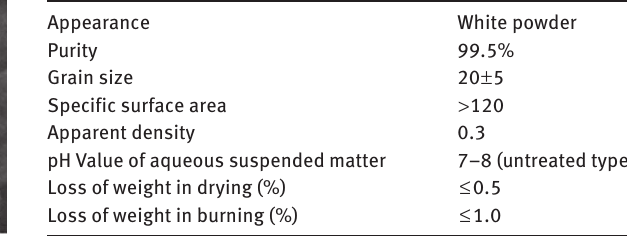
Table 1 Properties of nano TiO